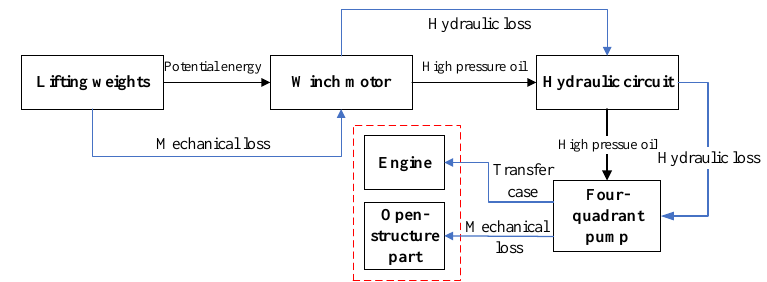
Figure 2. Energy transferred